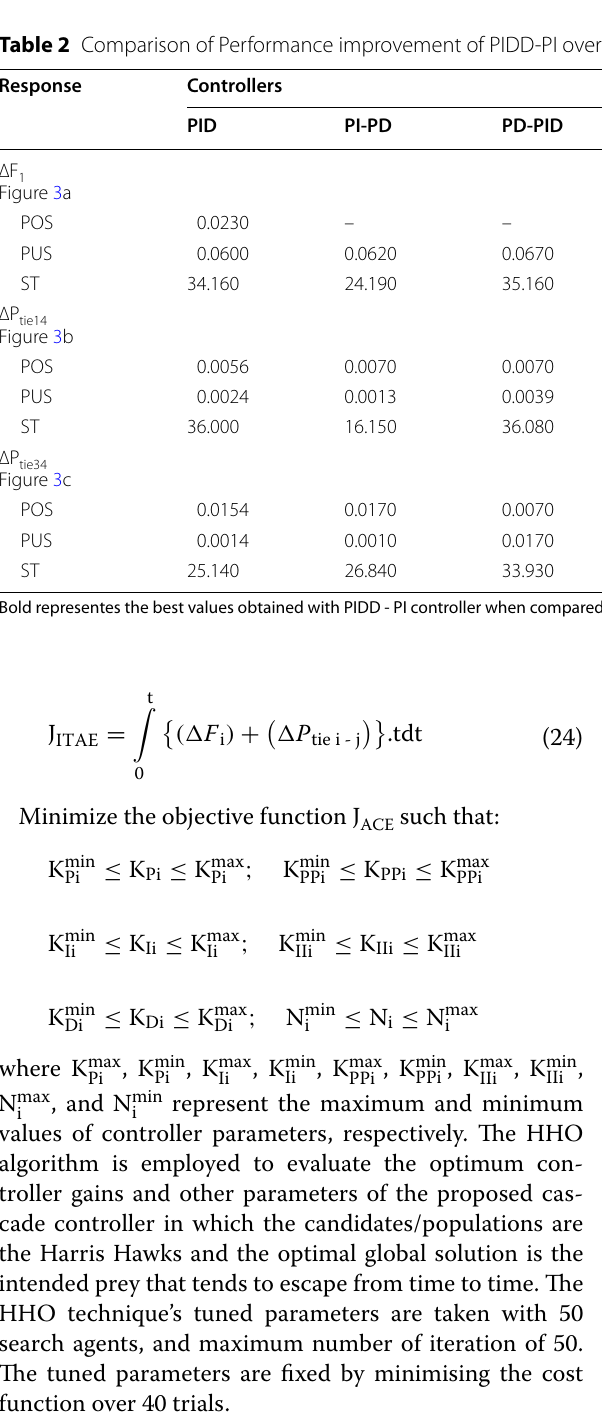
Table 2 Comparison of Performance improvement of PIDD-PI over PID, PI-PD and PD-PID controllers Response Controllers